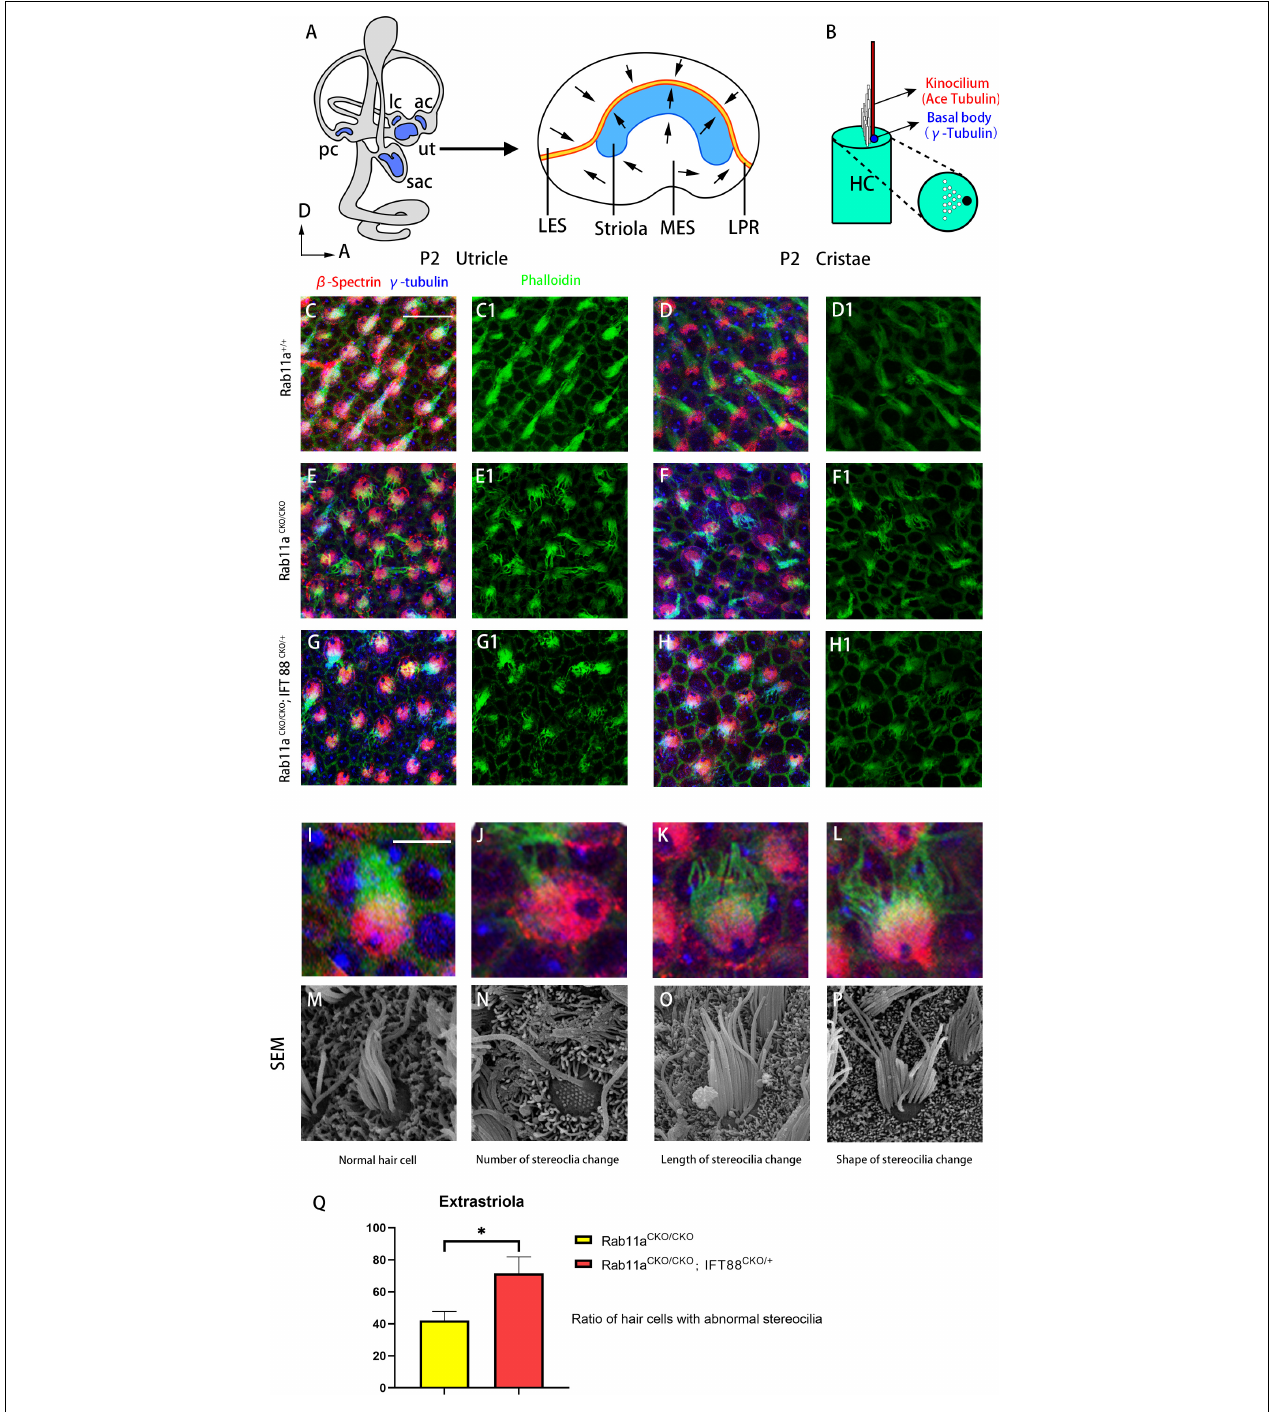
FIGURE 1 | Morphological changes of stereocilia in the extrastriolar hair cells from Rab11a single or Rab11a / IFT88 double-mutant utricles. (A) Medial view of a mouse left inner ear with its five vestibular sensory organs (gray). Enlarged are the utricle showing their subdivisions, LPR (yellow line), and striola (blue). LES, lateral extrastriola; MES, medial extrastriola; LPR, line of polarity reversal. (B) Schematic view of vestibular hair cell. Kinocilium is marked with ace-tubulin. Basal body is marked with γ -tubulin. (C,C1,D,D1) Normal appearance of the stereocilia of extrastriolar hair cells of wild-type controls. (E,E1,F,F1) Altered morphology in Rab11a CKO / CKO animals. (G,G1,H,H1) The changes in the stereocilia morphology were more severe in Rab11a CKO / CKO / IFT 88 CKO / + mice. (I–L) Higher magnification of confocal images of hair cells. (M–P) Scanning electron microscopy images of hair cells from wild-type controls and Rab11a mutants. (I,M) Morphology of normal. hair cells of wild-type controls. (J,N) The number of stereocilia on a single hair cell was deceased in the Rab11a mutant. (K,O) Stereocilia were shorter in